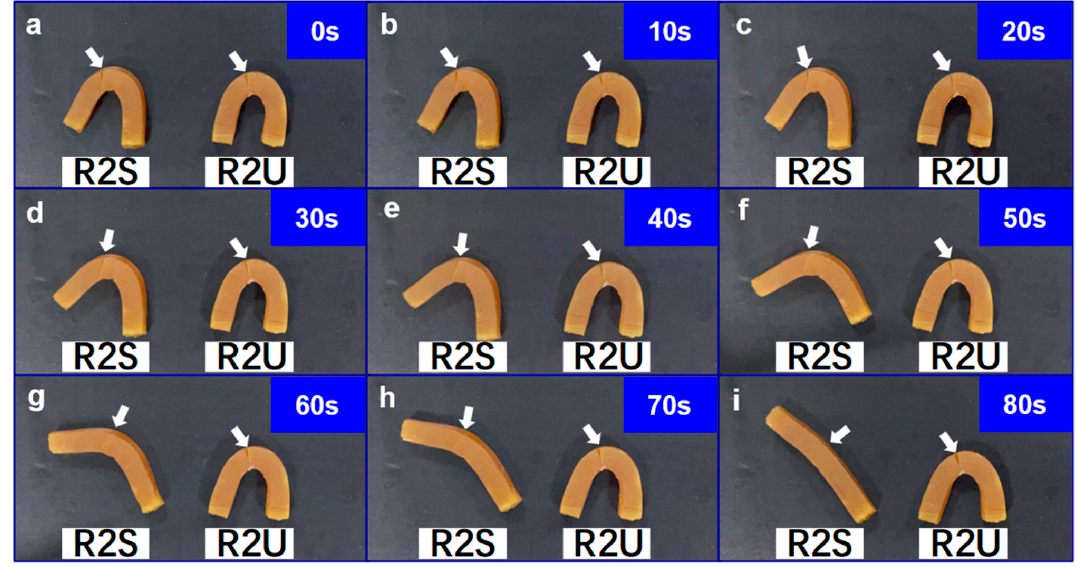
Figure 10. Schematic illustration of the shape memory assisted self-healing process.